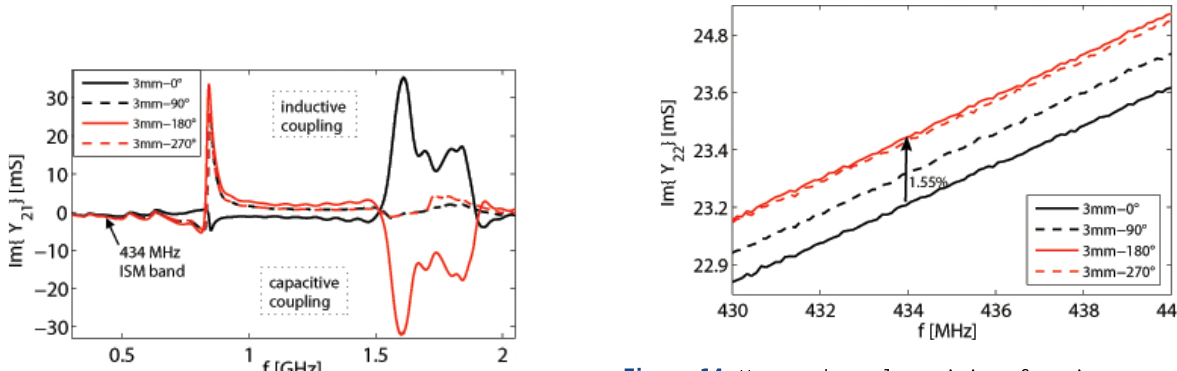
Figure 14. Measured angular variation of receiver susceptance Im( Y 22 ) in extended ISM frequency band for a 3mm gap. Table 1. Measured coupler transmission Im( Y 21 ) and